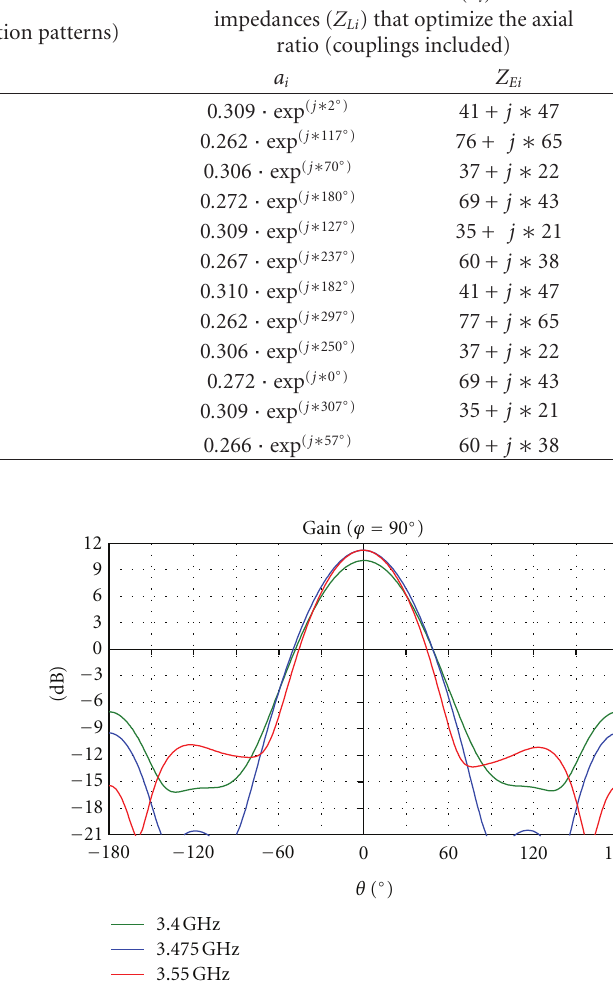
Figure 13: Realized gain obtained in simulation with the substrate losses